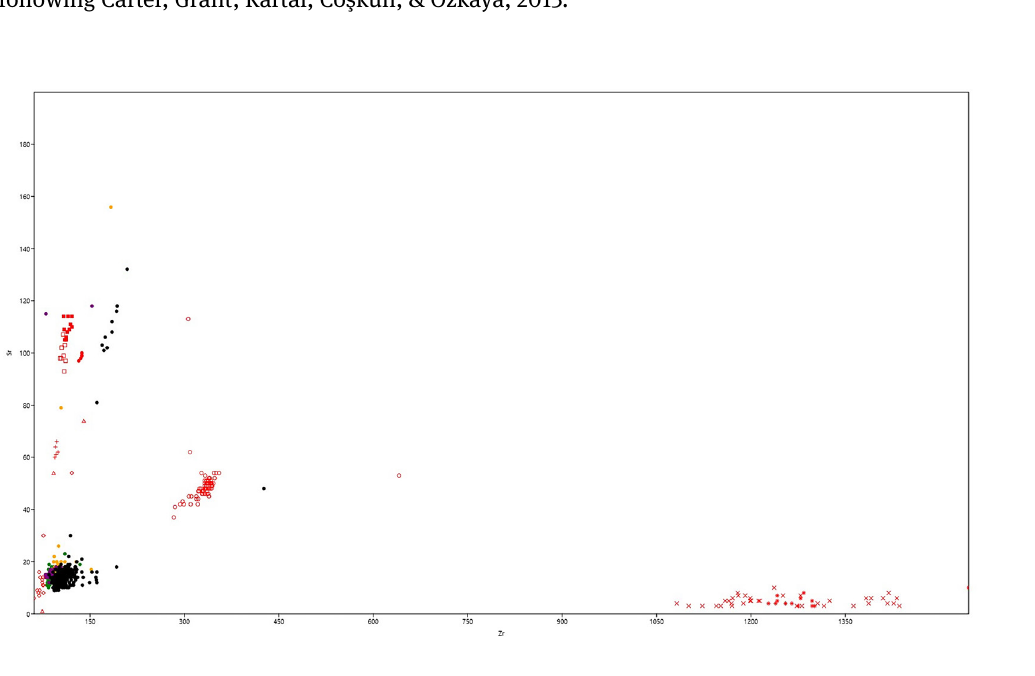
Figure 3 . Bivariate plot of Sr vs. Zr for Cypriot obsidian artefacts from Early Aceramic Neolithic assemblages and geologi- cal sources from the circum-Mediterranean region. [Note: Sources are in red colour Diamond=Göllüdağ, Dot=Nenezi Dag, Square=Melos Adamas, Filled square=Melos Demenegaki, Plus=Giali, Triangle= Acigöl, Circle=Bingöl B, Cross=Bingöl A, Star=Nemrut Dag and Sites are Tenta =purple, Mylouthkia =orange, Ais Giorkis =green, Shillourokambos =black, Arkosyko (covered by the Shillourokambos main